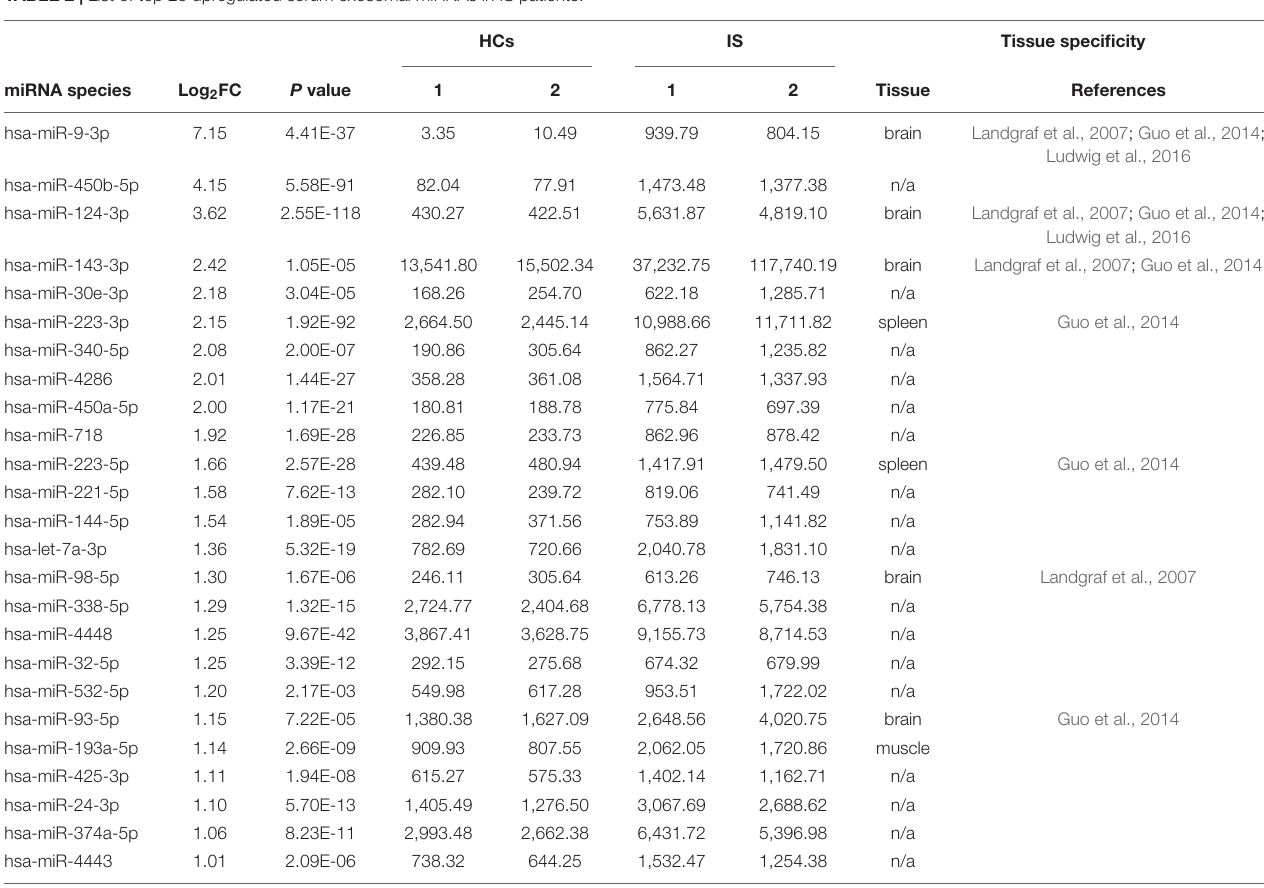
TABLE 2 | List of top 25 upregulated serum exosomal miRNAs in IS patients. HCs IS Tissue